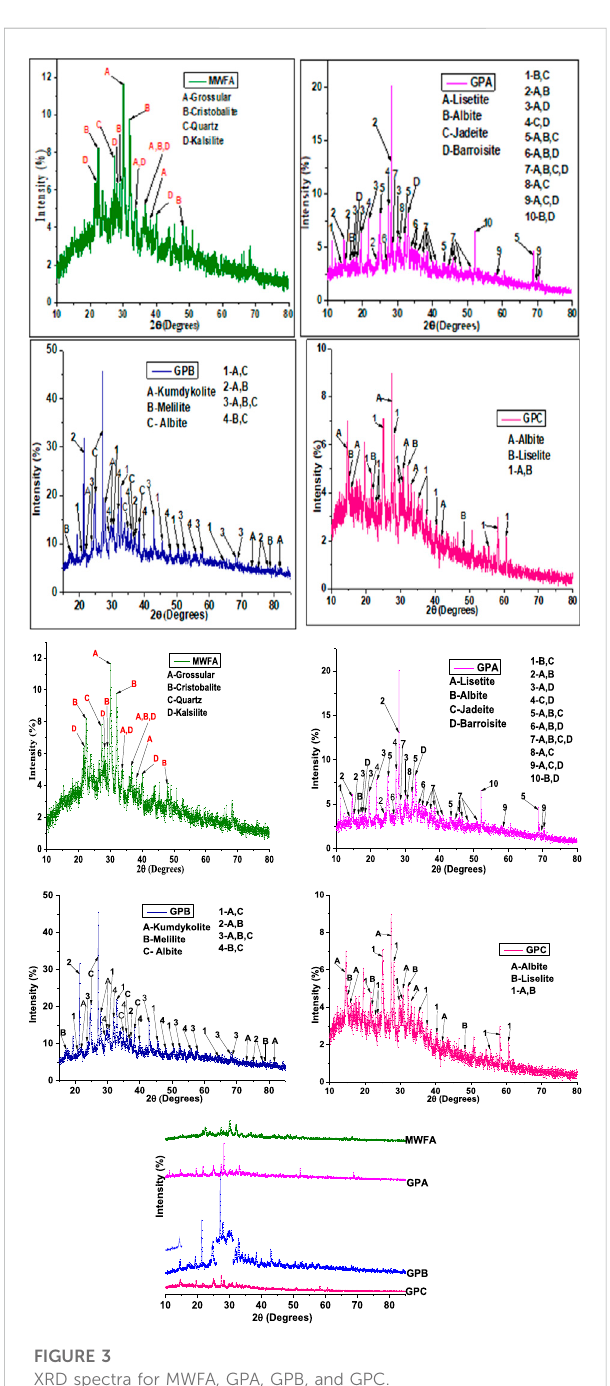
FIGURE 3 XRD spectra for MWFA, GPA, GPB, and GPC.